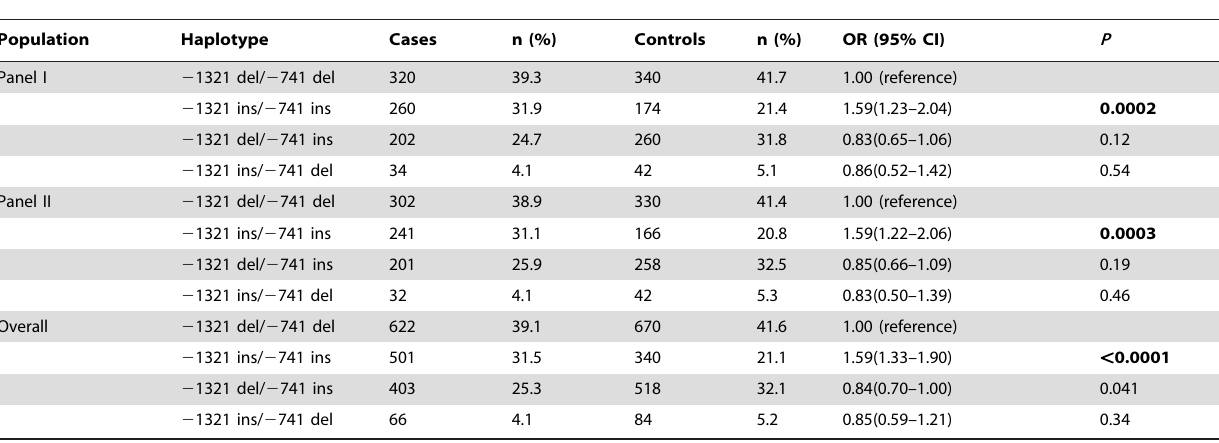
Table 6. Association between BRM promoter haplotypes and risk of HCC a .